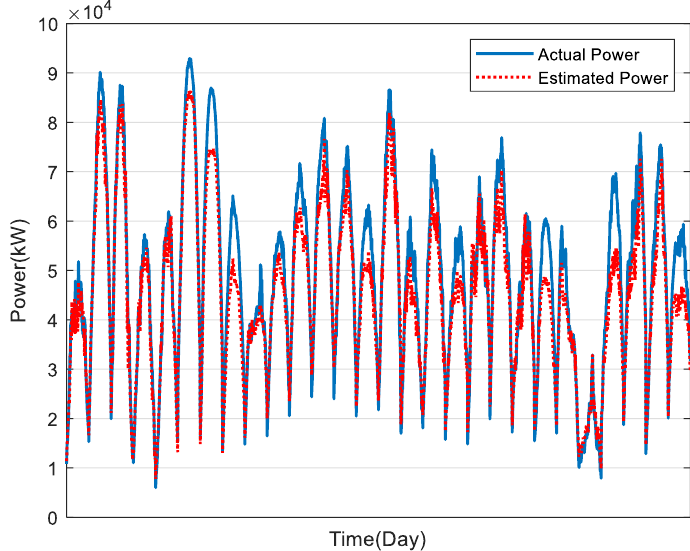
Figure 12. Results of PV power estimation in February.